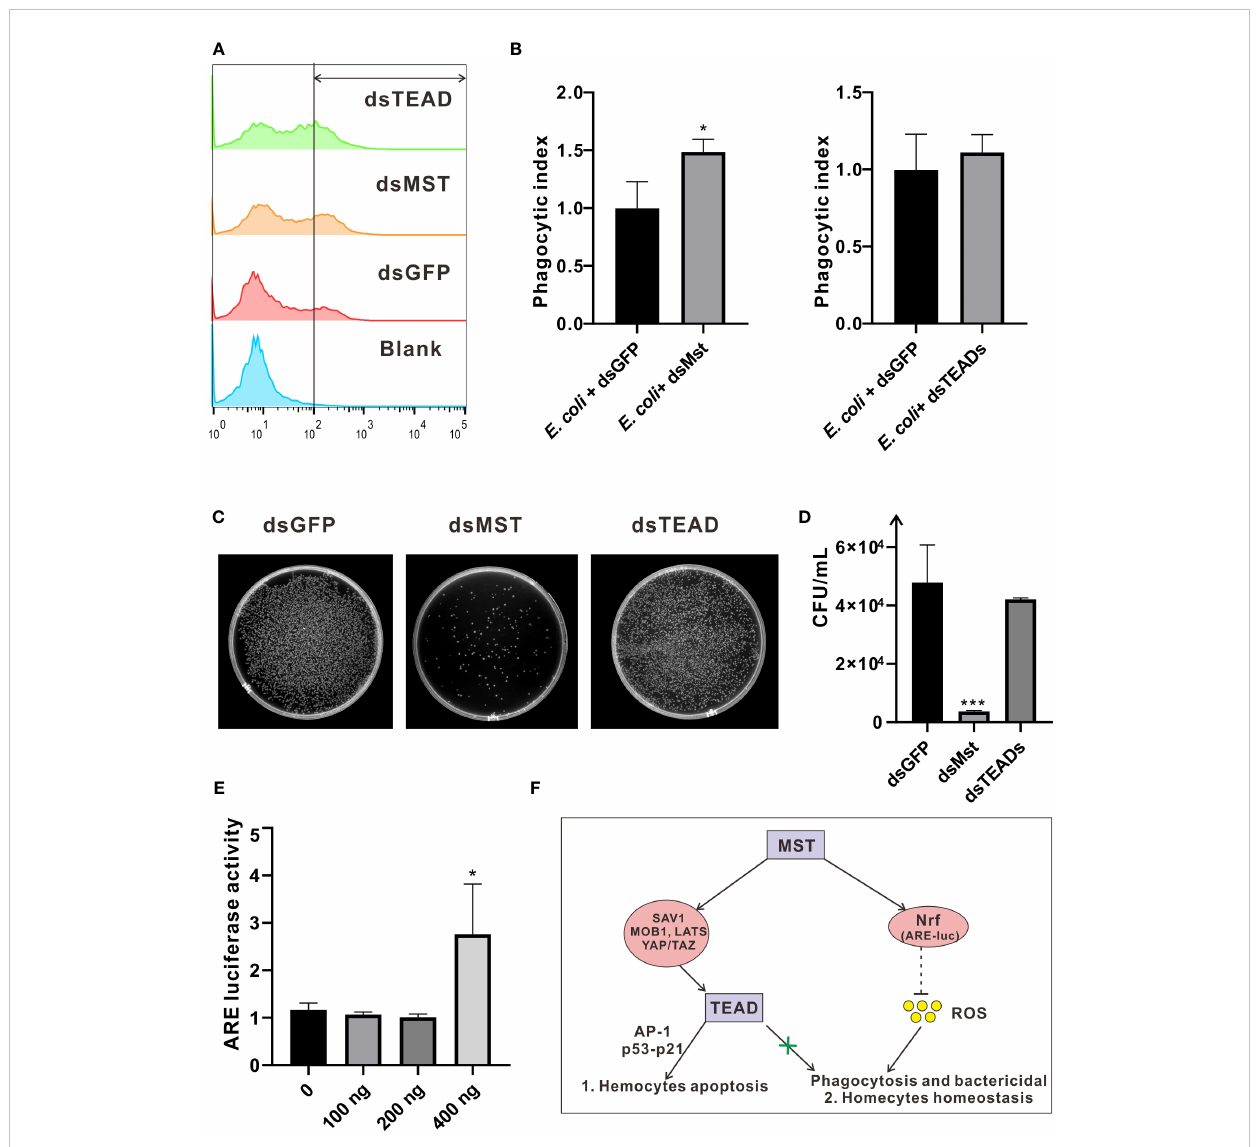
FIGURE 8 Roles of Ch MST in regulating hemocytic phagocytosis and bactericidal activity. (A) Hemocytic phagocytosis was detected by fl ow cytometry. Phagocytosis rates for E coli and the blank (PBS) control group were calculated and compared. (B) Phagocytic index was calculated to represent the effects of Ch MST (left panel) and Ch TEAD (right panel) in phagocytosis. Data analysis was performed by using GraphPad Prism 9 software, and vertical bars represent mean ± SD ( n = 3). * p < 0.05. (C) Representative images for outcomes of bactericidal activity following an infection assay in hemocytes, with genetic knockdown of Ch MST or Ch TEAD. (D) Bactericidal survival rates were calculated by using Image J and presented with GraphPad Prism 9. Data were analyzed by unpaired t -test and presented as mean ± SD. ∗∗∗ p < 0.001, n = 3. (E) Relative luciferase activity of ARE after overexpression of Ch MST. Data analysis was performed by using GraphPad Prism 9 software, and vertical bars represent mean ± SD ( n = 3). * p < 0.05. (F) Conceptual framework of Hippo signaling in C hongkongensis